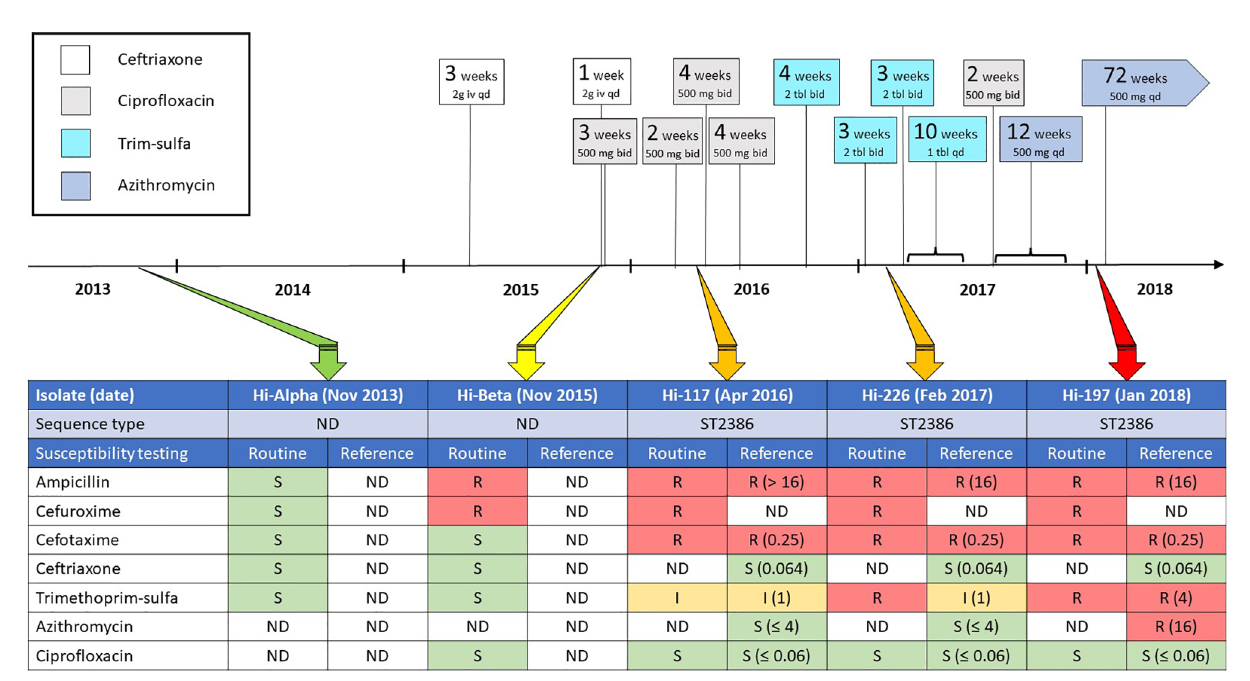
FIGURE 1 | Time scale annotated with exposure to antibiotics (including dosages), along with results from phenotypic antimicrobial susceptibility testing (AST) to relevant antibiotics for fi ve H. in fl uenzae isolates sampled between November 2013 and January 2018. The Hi-Alpha and Hi-Beta isolates were not available for genomic characterization, and their potential phylogenetic relationship to the Hi-117, Hi226 and Hi-197 isolates could not be explored. Routine AST results for the fi ve isolates represent primary testing with disk diffusion and/or gradient diffusion, whereas reference AST results were produced retrospectively by determination of broth microdilution (BMD) MIC using custom panels. Disk diffusion and BMD were done according to the standards of the EUCAST, while gradient diffusion was performed according to the manufacturer ’ s recommendations. AST results were interpreted using EUCAST clinical breakpoints (v. 12.0), except azithromycin (no clinical breakpoints), for which susceptibility categorization was based on the epidemiological cut-off value (4 mg/L). bid, twice daily; qd, once daily; Trim-sulfa, trimethoprim-sulfamethoxazole; S, susceptible; I, intermediately susceptible (changed to “ susceptible, increased exposure ” from 2019); R, resistant; ND, no